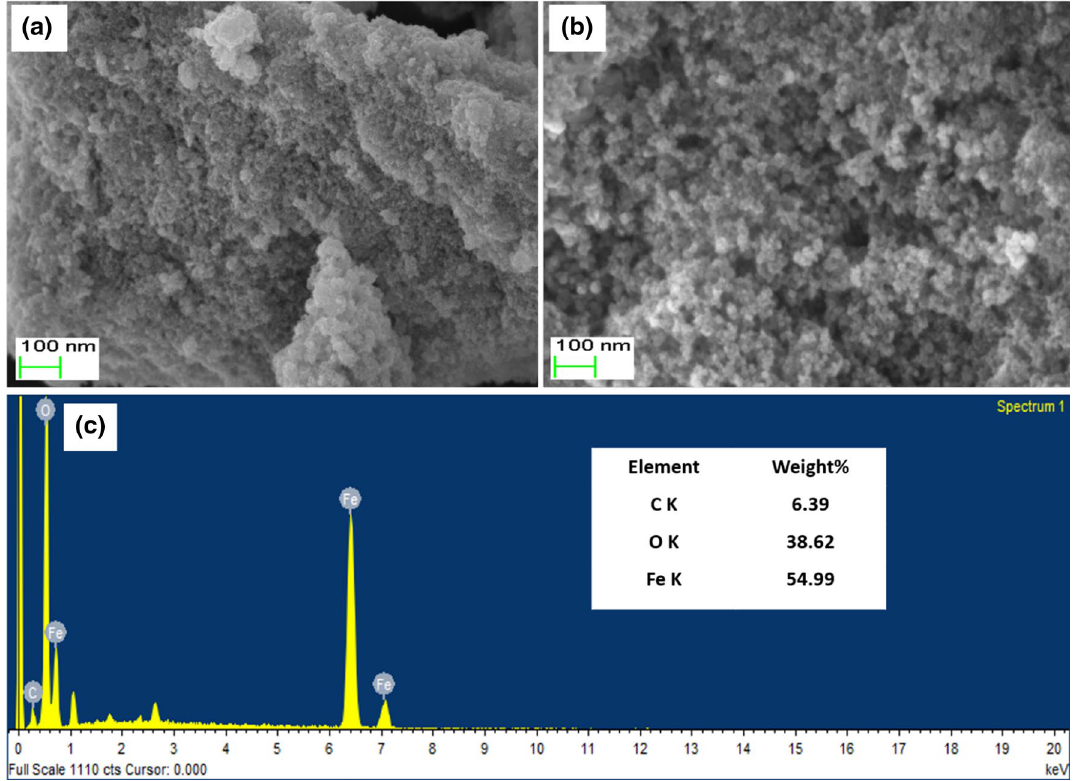
Fig. 4 The representative SEM images of a uncapped Fe 3 O 4 NPs, b L-Asp capped Fe 3 O 4 NPs, and c EDS spectrum L-Asp capped Fe 3 O 4